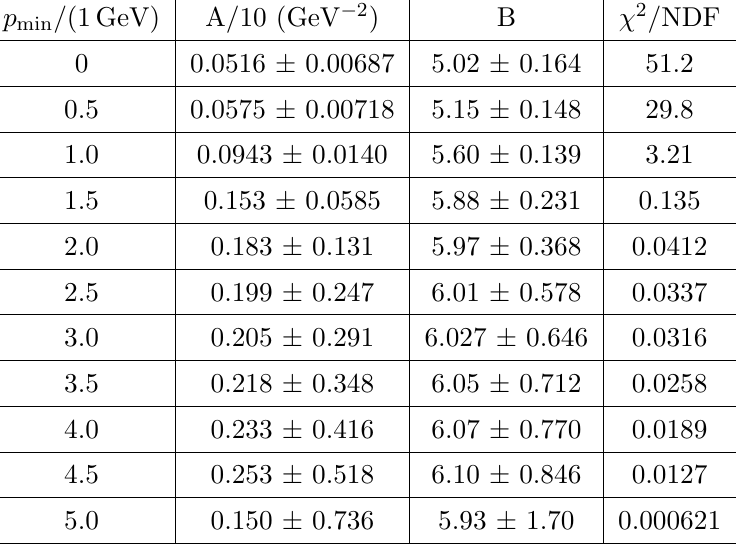
Table 2. Fitted values of parameters in eq. (E.2) for the ATLAS dataset at p s = 8 TeV [94]. instead of the two-parameter form presented in eq. (E.2). This form has two advantages. First, for C > 0, the numerical singularity at p ? = 0 is directly removed; additionally,